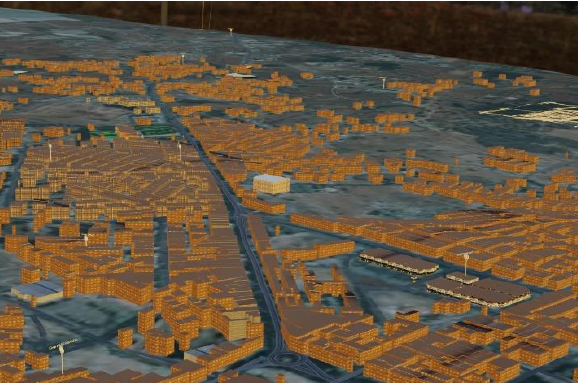
Figure 14 . Cooperatives location in Biougra city 3d model